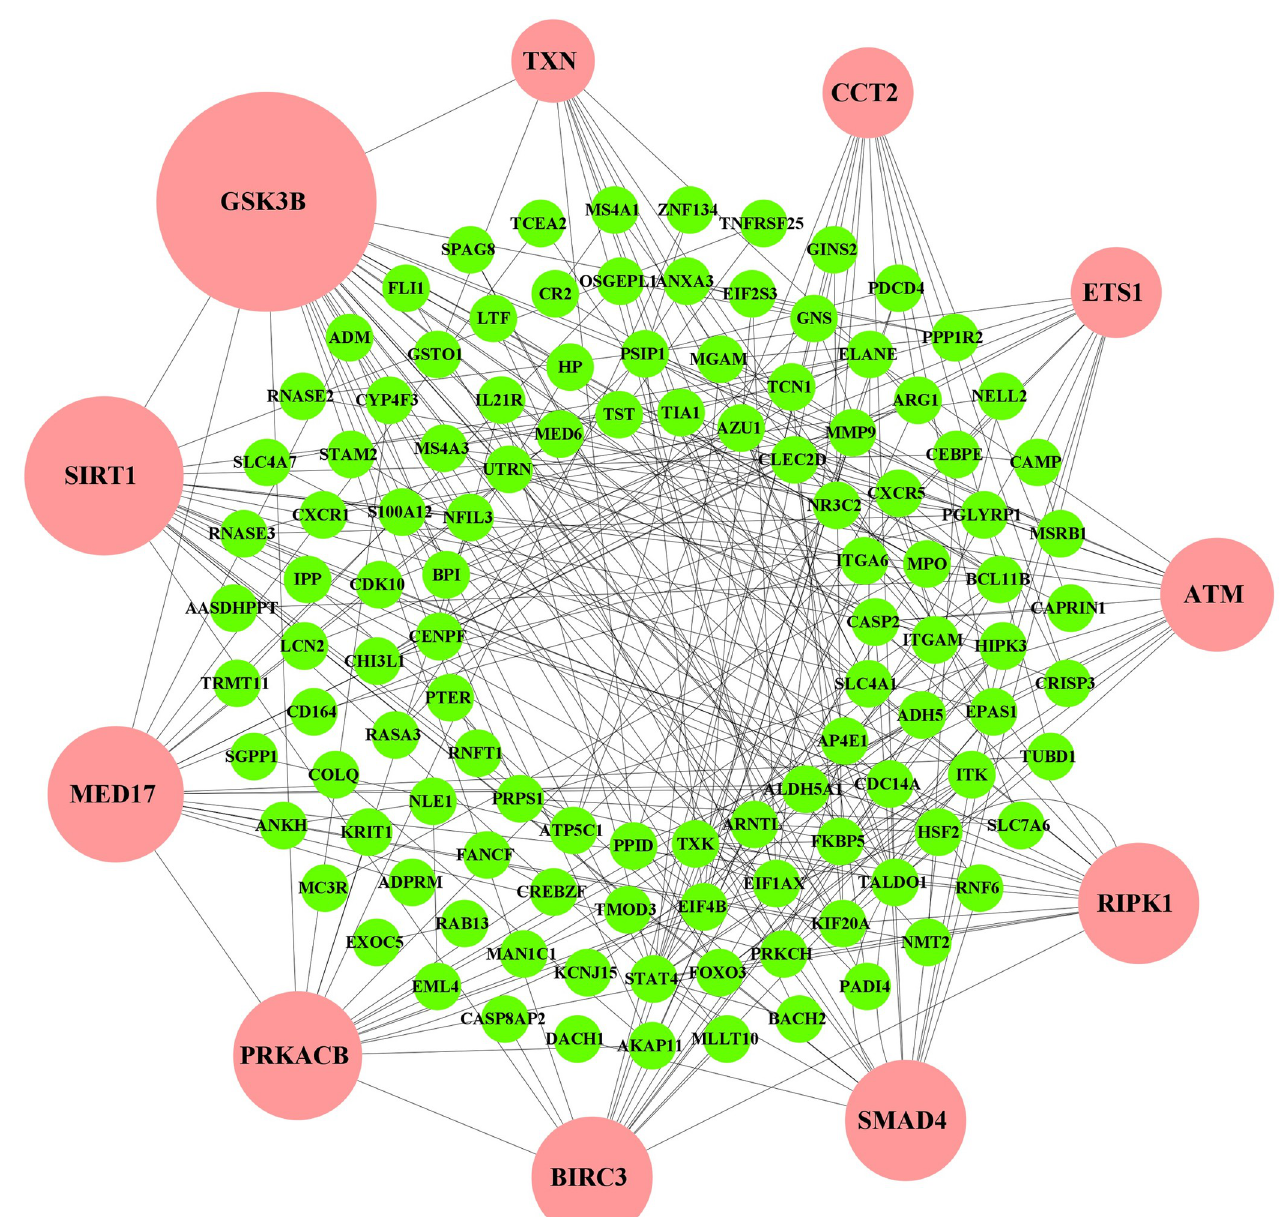
Fig 3. PPI network of DEGs. The larger nodes highlighted with pink color indicate the